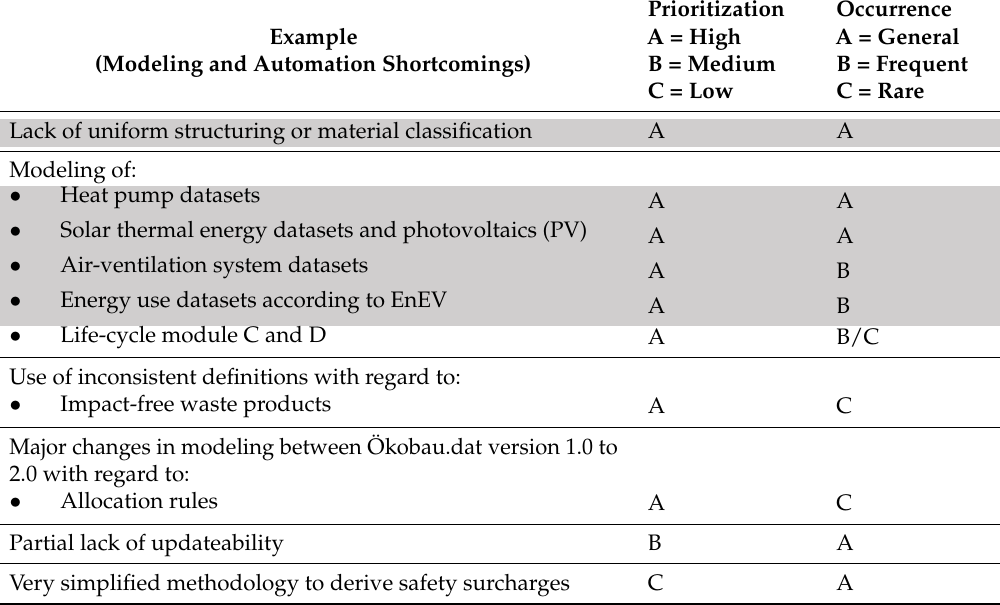
Table 4. Modeling and automation related shortcomings–Examples and their prioritization for solution-oriented